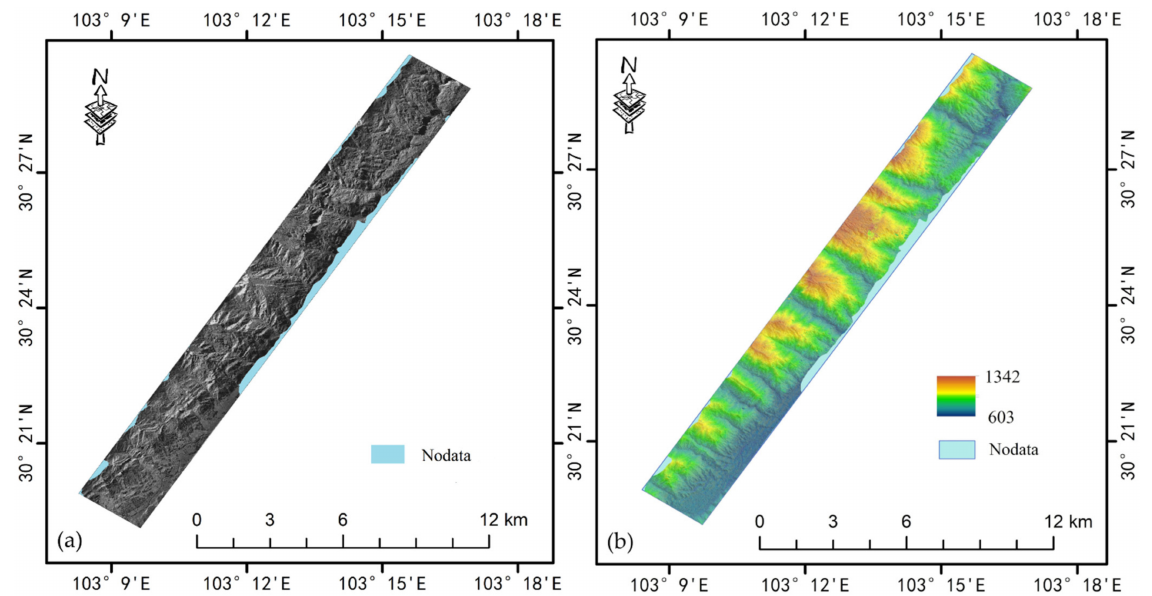
Figure 14. The obtained DOM ( a ) and DSM ( b ) of the Qionglai experimental